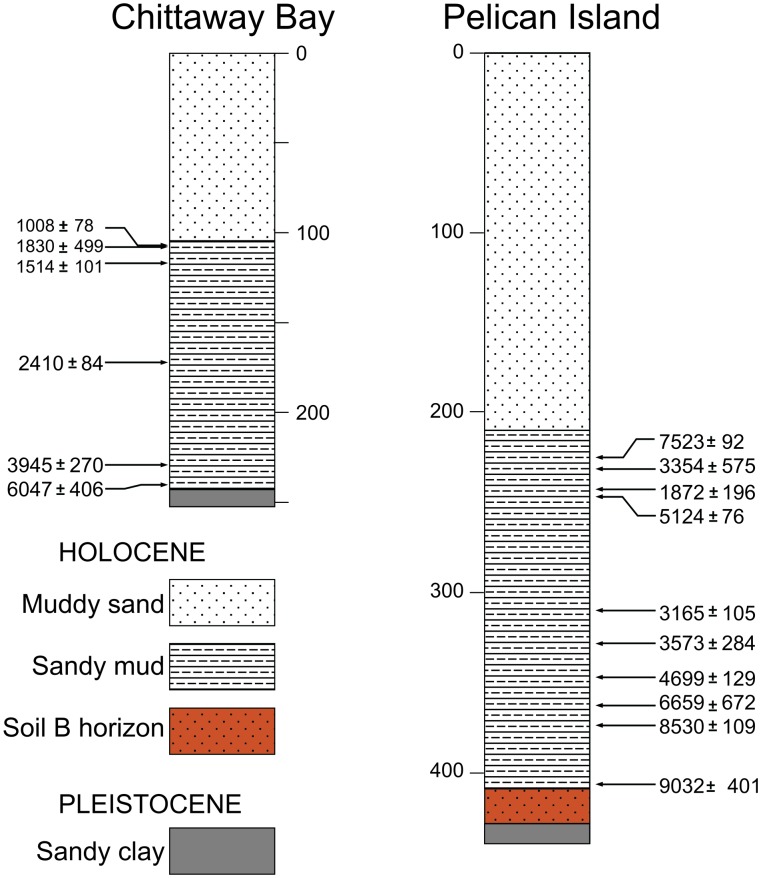
Sediment cores taken from Chittaway Bay and Pelican Island showing how sediment type changes with depth (cm) down core and age (14C data, mean ± SE).